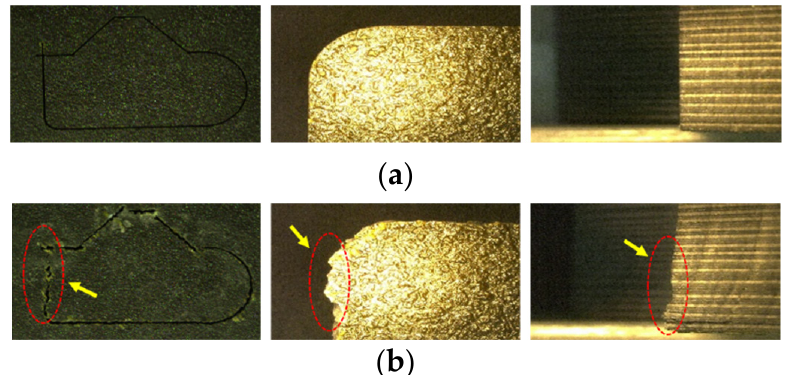
Figure 5. Nozzle bore diameters and weights at a waterjet pressure of 350 MPa and an abrasive feed rate of 450 g/min.